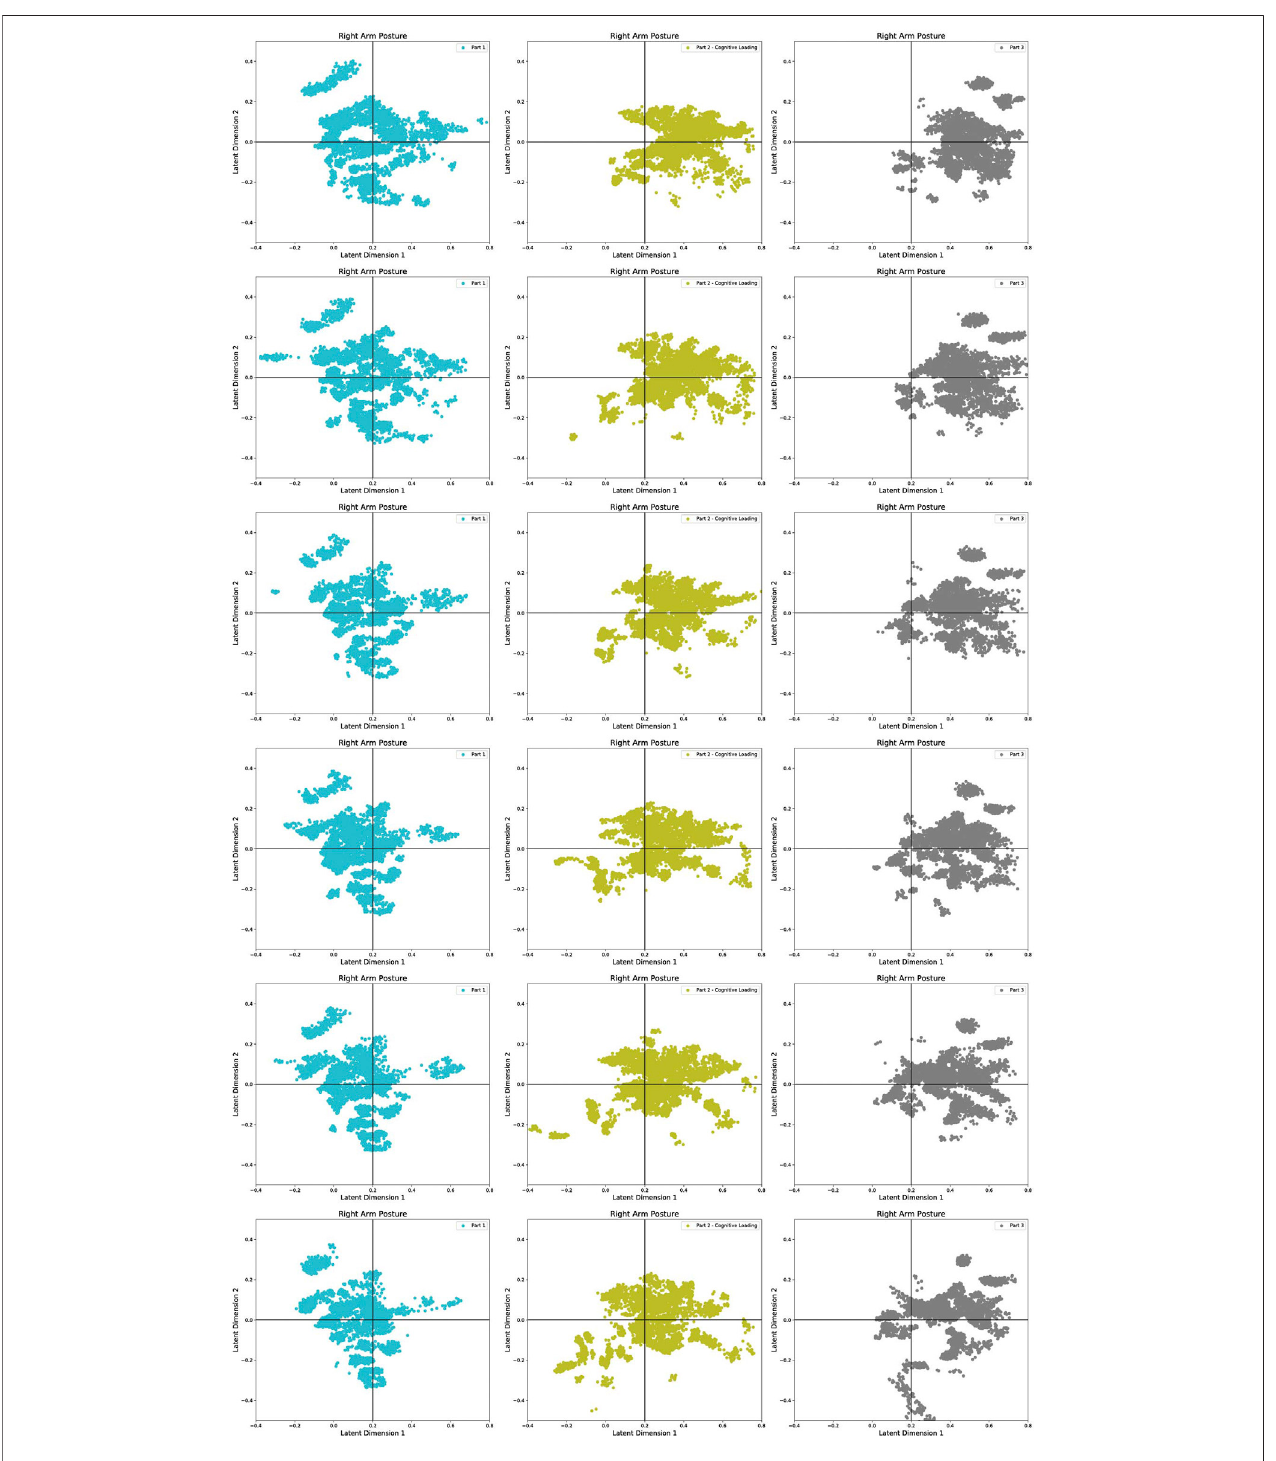
FIGURE 13| Comparison of latent spaceprojections during different parts ofthe experiments along the progression in thedressingsequence. The progression of Part One is represented by the LHS column, Part Two by middle columns and Part Three by the RHS column.